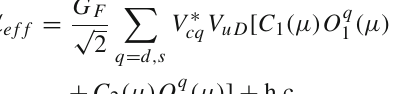
diagrams in which the final state particles share the quarks from the weak vertex; B indicates W exchange mechanism with weakly gener- ating quarks taken all by the final state baryon. Decays calculated in this paper receive no contribution labeled by B , although it is listed